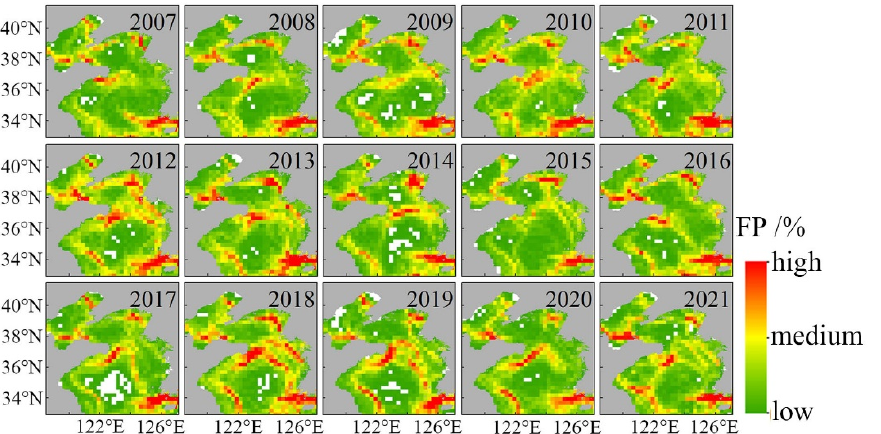
Figure 11. Interannual frontal probability maps of YSRF for 1982–2021.